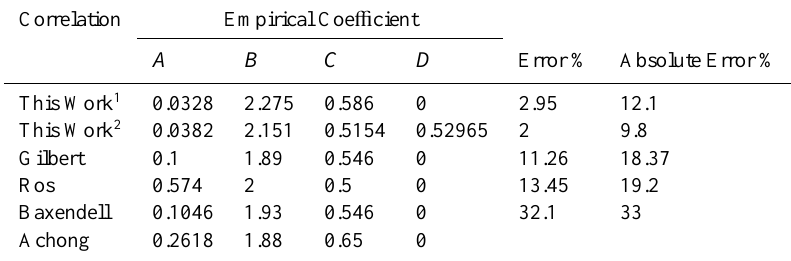
) D B ( 1 − BS&W 100 ). GLR C